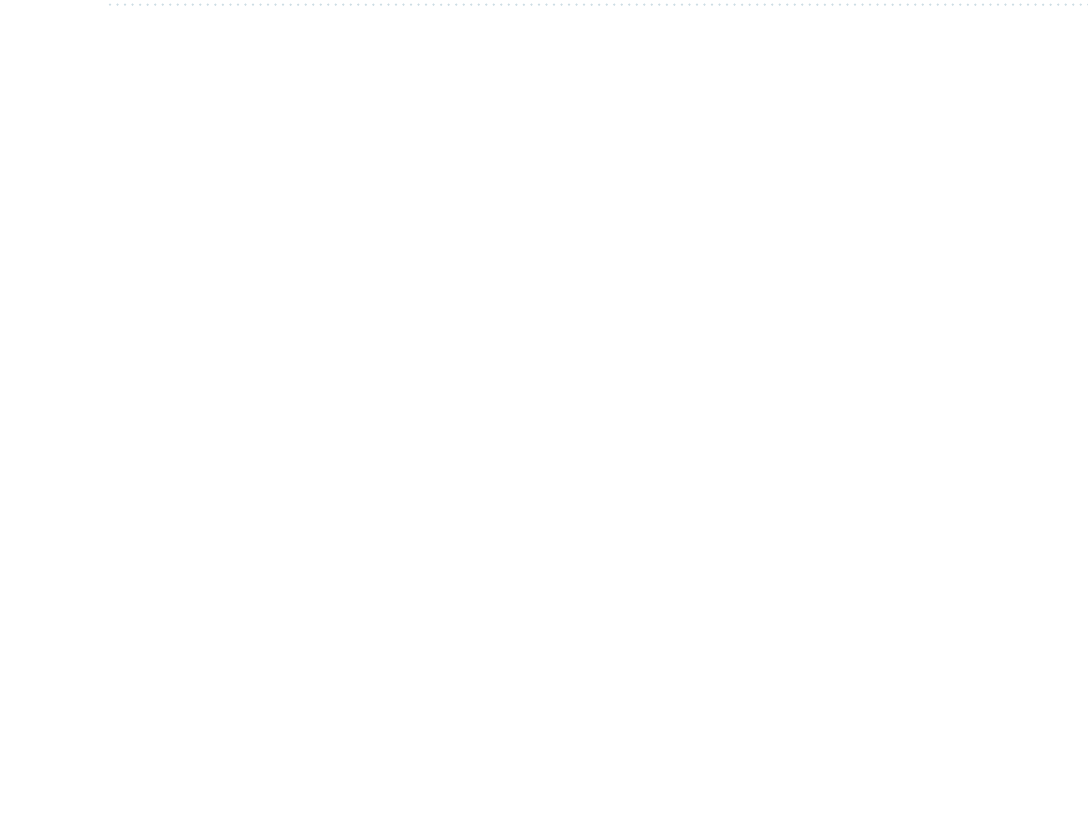
Figure 14. Classification maps of different models on the PU dataset. ( a ) False-color image. ( b ) Ground-truth map. ( c ) MLP. ( d ) 1D-CNN. ( e ) M3D-DCNN. ( f ) SSRN. ( g ) pResNet. ( h ) DBDA. ( i ) SCFR. ( j ) DPSCN. ( k )